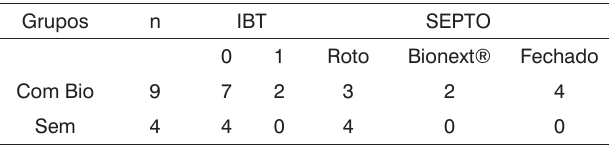
septo(Bt= Bionext® entre os bordos da perfuração) Tabela 2. Alterações histológicas observadas, em relação à integri- dade do biomaterial e características do septo, de acordo com os grupos